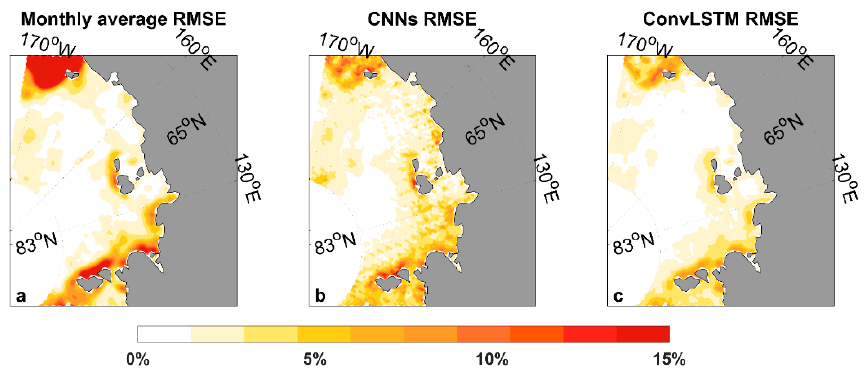
Figure 12. Comparison of the RMSE between the monthly average ( a ), CNNs ( b ) and ConvLSTM ( c ) data near the Eastern Siberian sea area. The meanings of each color in this figure are the same as those in Figure 11.